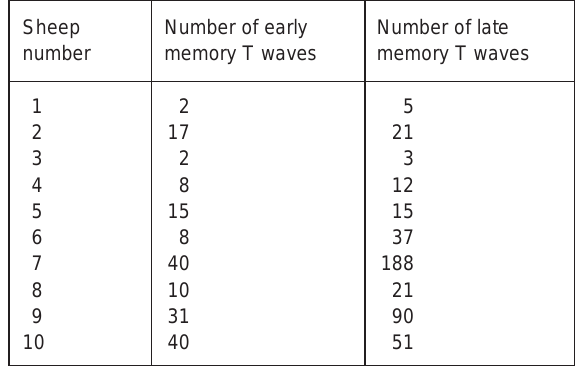
TABLE 2 Early versus late cardiac memory T